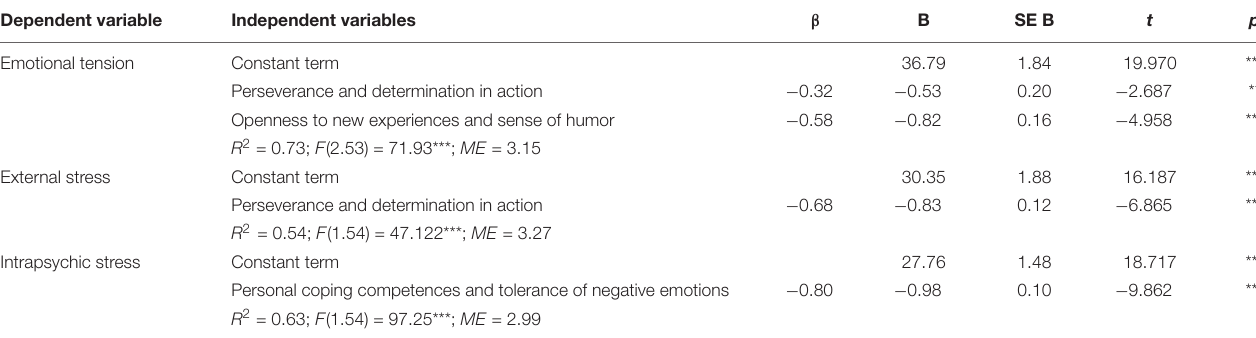
TABLE 4 | Multiple regression analysis results with stress dimensions as the dependent variable and resilience during the COVID-19 pandemic as the independent variable. Dependent